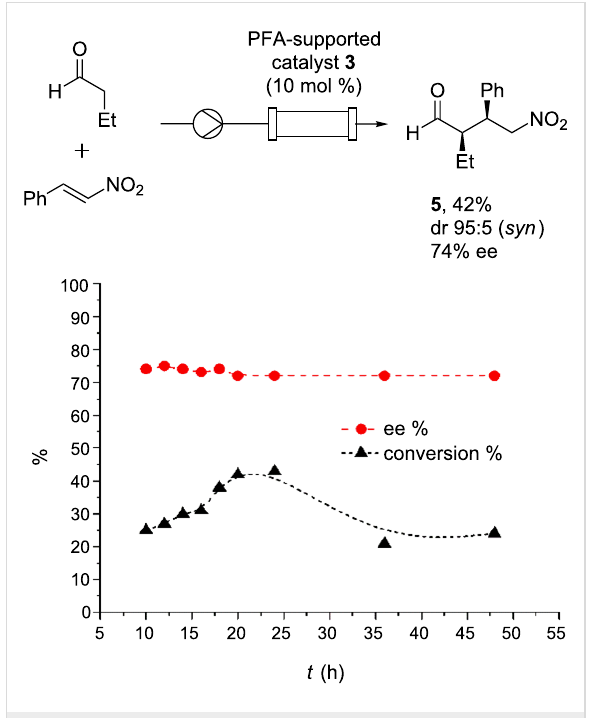
Figure 1: Analysis of the continuous-flow catalytic system producing γ -nitroaldehyde 5 with PFA-supported catalyst 3 packed in a microre-